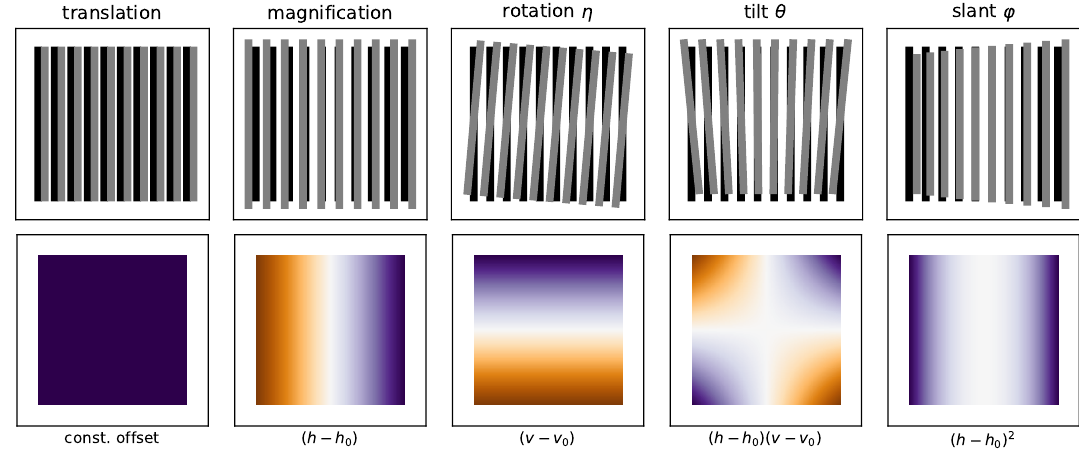
Figure 5. Grating misalignments (top row) and corresponding spatial phase variations (bottom row). From left to right: Translation, magnification, rotation, tilt, and slant. The latter two effects (as well as translation induced magnification) are only observable in cone beam setups. The employed color bar ranges from orange for negative values over white (zero) to blue for positive